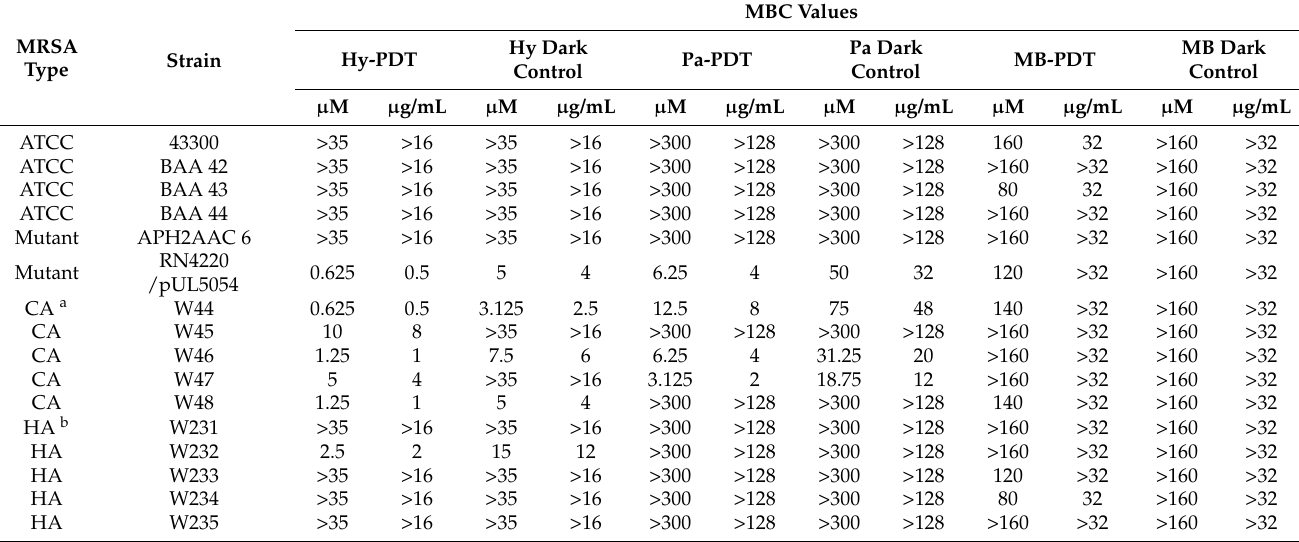
Table 2. The Minimal Bactericidal Concentrations (MBCs) of Pa, Hy and MB against sixteen MRSA